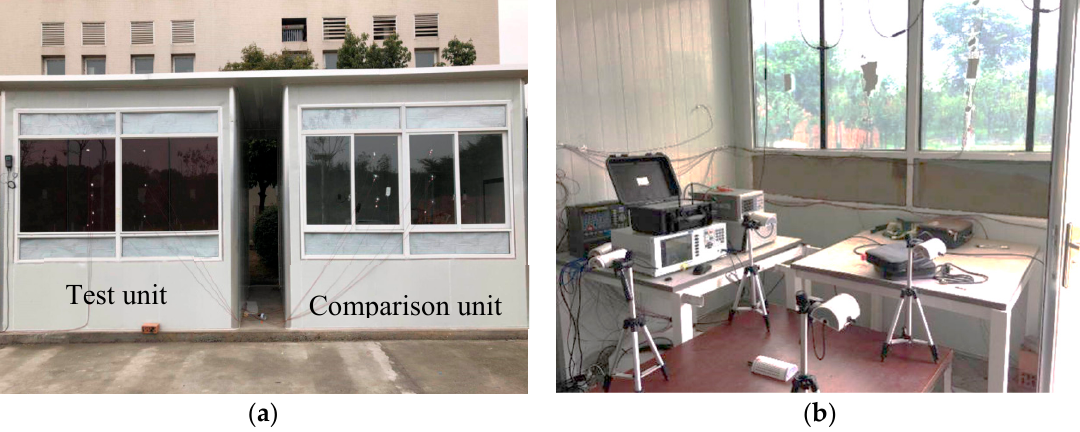
Figure 3. The ( a ) outside and ( b ) inside of the test rig.